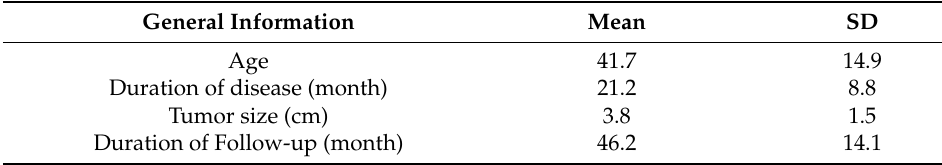
Table 1. Demographic and clinical information of